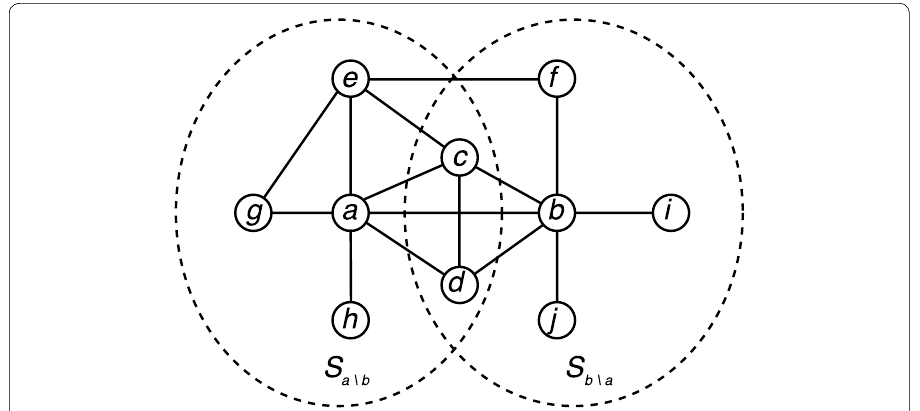
Fig. 2 The sets of the nodes of the edge-ego-network G ab in the case (d) of Fig. 1. S a \ b contains node a and its neighboring nodes except node b ; S b \ a contains node b and its neighboring nodes except node